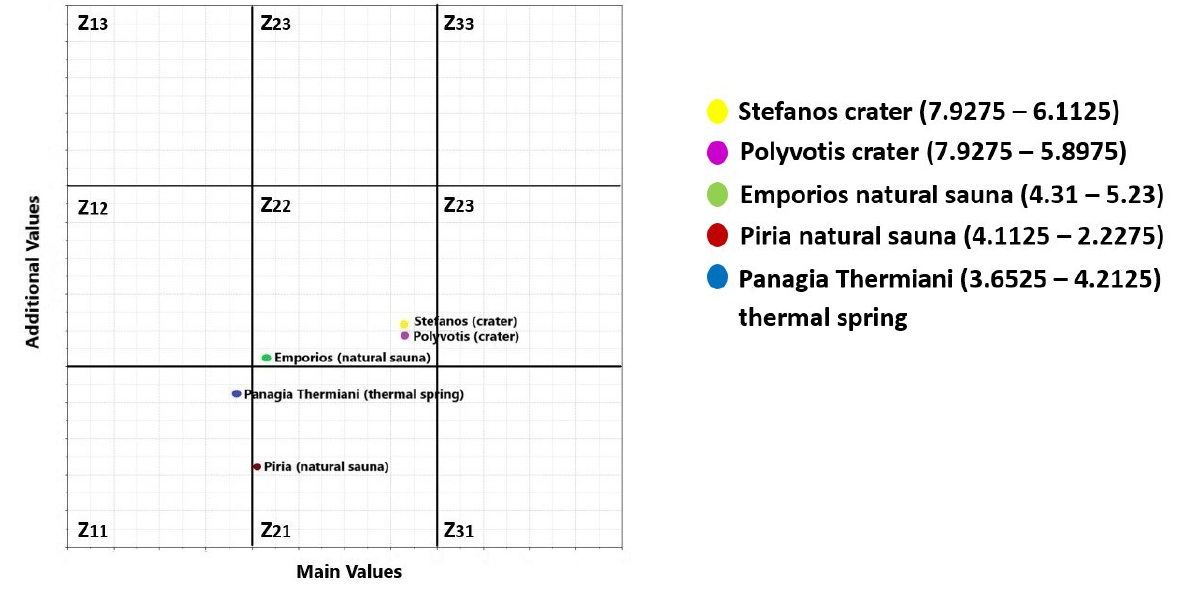
Figure 10. The display of results from the M-GAM